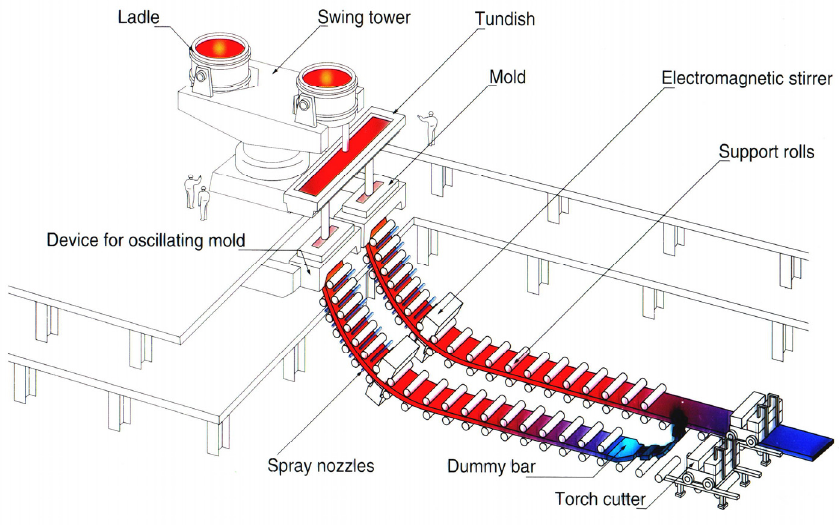
Figure 2. Typical process layout and equipment for various forms of continuous casting; Two-strand continuous slab caster [4].